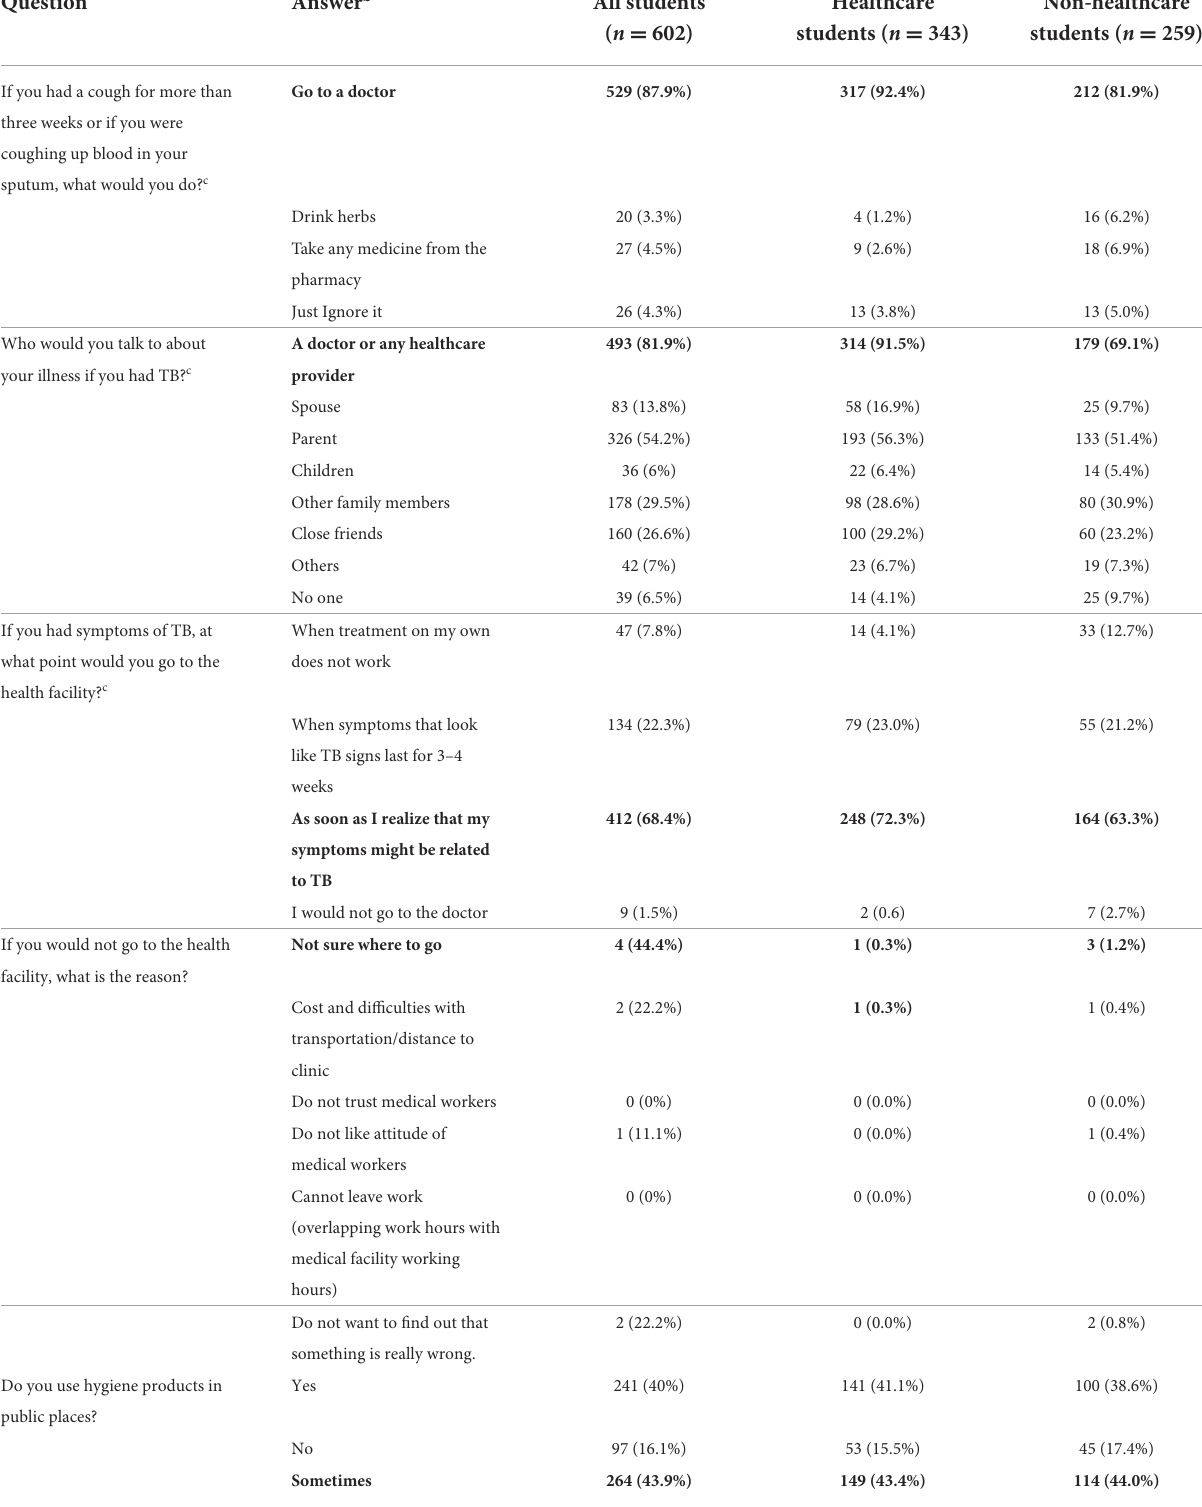
TABLE 5 Practices related to TB and respiratory diseases among university students a . Question Answer b All students